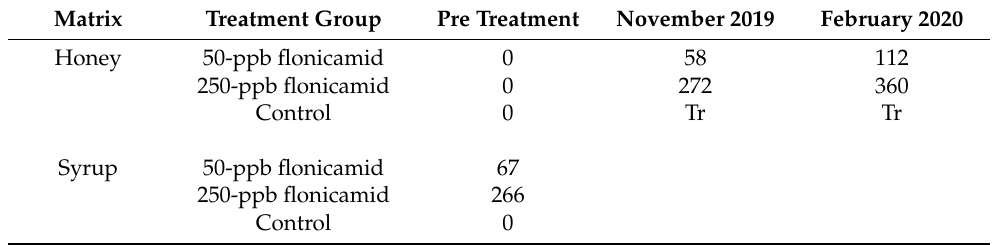
Table 1. Flonicamid concentrations in honey (sampled from bee hives) and in the sugar syrup treatment. Matrix Treatment